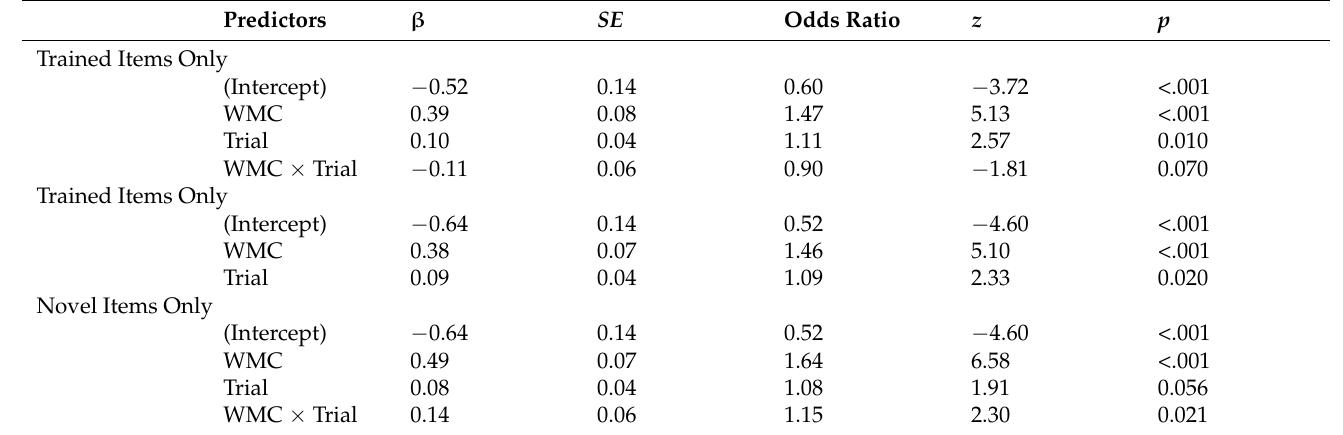
Table A3. Post hoc comparisons: WMC × training × trial.